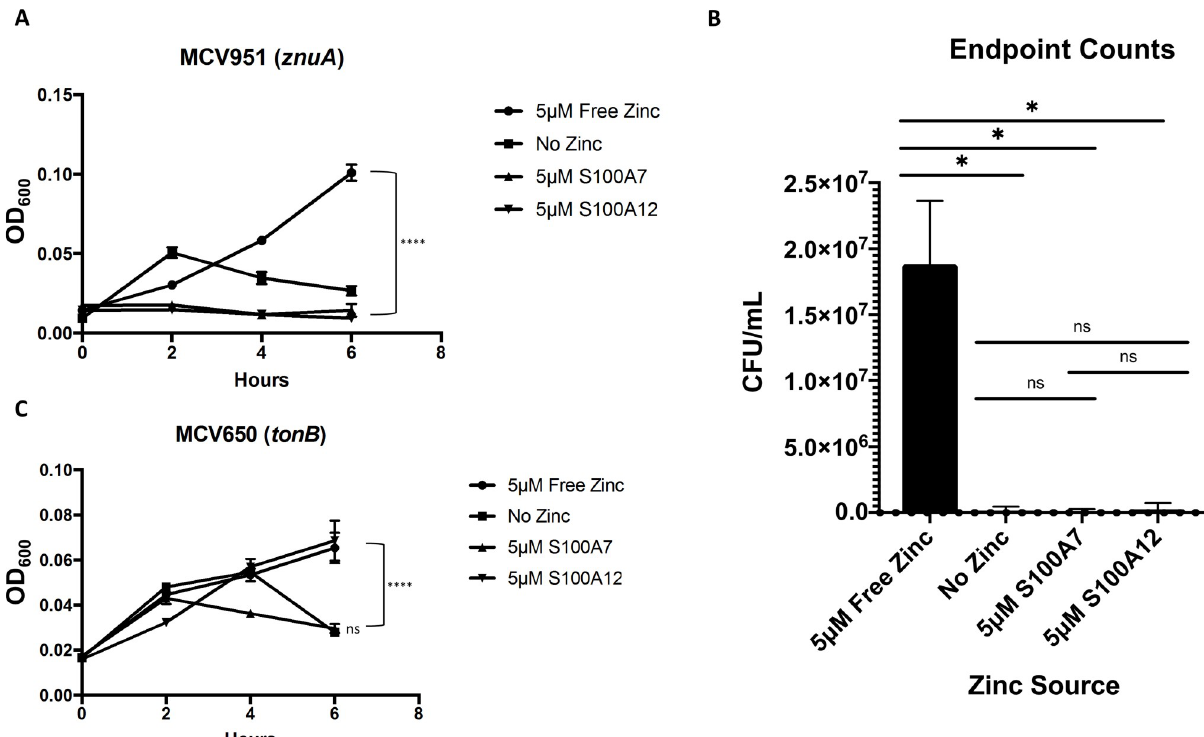
Fig 5. S100A7 utilization during growth depends on ZnuA and TonB. (A) N . gonorrhoeae mutant strain MCV951 ( znuA ) was grown in Zn-limited conditions in defined media (CDM), which was supplemented with growth premix containing either ZnSO 4 , S100A7, S100A12, or no zinc. Growth was measured by OD 600 readings every 2 h for 6 h total. (B) The znuA mutant strain, MCV951, was submitted to liquid growth assays to assess its ability to utilize free zinc and zinc bound to either S100A7 or S100A12. After 6 hours of assay time, samples grown with each zinc source were collected, serially diluted in PBS, and spotted onto GCB plates supplemented with 5 mM D-Mannitol. After incubation for 24 h, colonies were enumerated to demonstrate that this strain does indeed grow in the presence of useable zinc despite the inability to produce the ZnuA protein. Significance was calculated using an unpaired Welch’s T-test performed on N = 3 assay sets. (C) N . gonorrhoeae mutant strain MCV650 ( tonB ) was also grown in Zn- restricted CDM, but to overcome the mutant’s inability to utilize iron from human transferrin, growth premix was instead prepared with 3 μ M Fe (NO 3 ) 3 with iron chelators excluded. Both graphs demonstrate means and SD for N = 3 independent experiments. A 2-way repeated measures ANOVA with Tukey’s correction was performed for all means, with significance at 6 h shown. � , P � . 05; �� , P � .005; ��� , P � .0005; ���� , P � .0001.